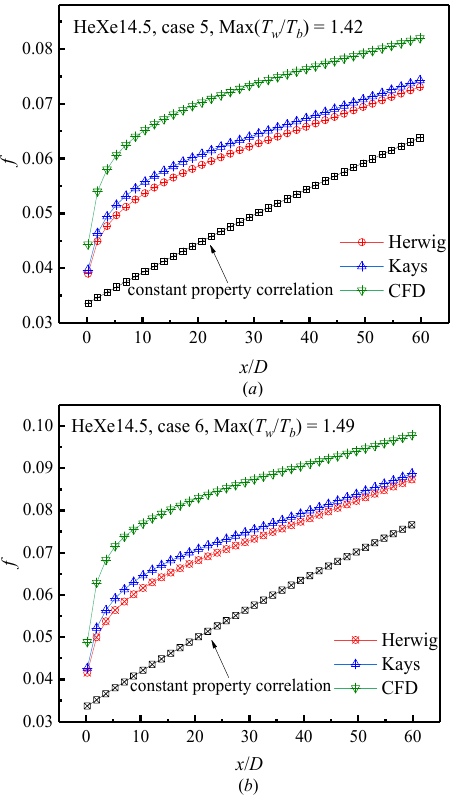
Figure 5. Calculations by existing f correlations for HeXe14.5. ( a ) case 5; ( b ) case 6. Table 6. Calculation errors of HeXe14.5 by laminar f correlations with case 6.